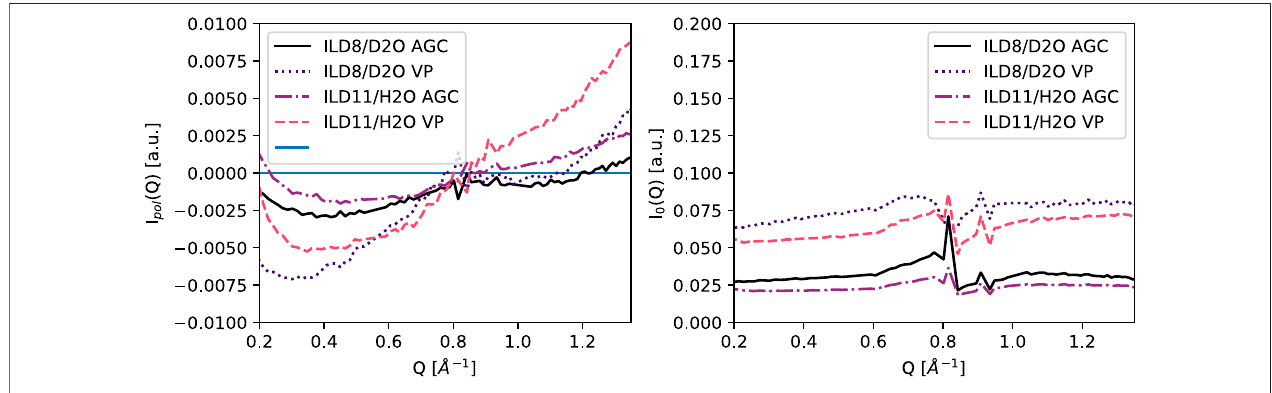
FIGURE 4 | Measured polarized intensity (Up-Down)/2 and average intensities (Up + Down)/2 at 265 K, normalized to the TiZr reference sample.